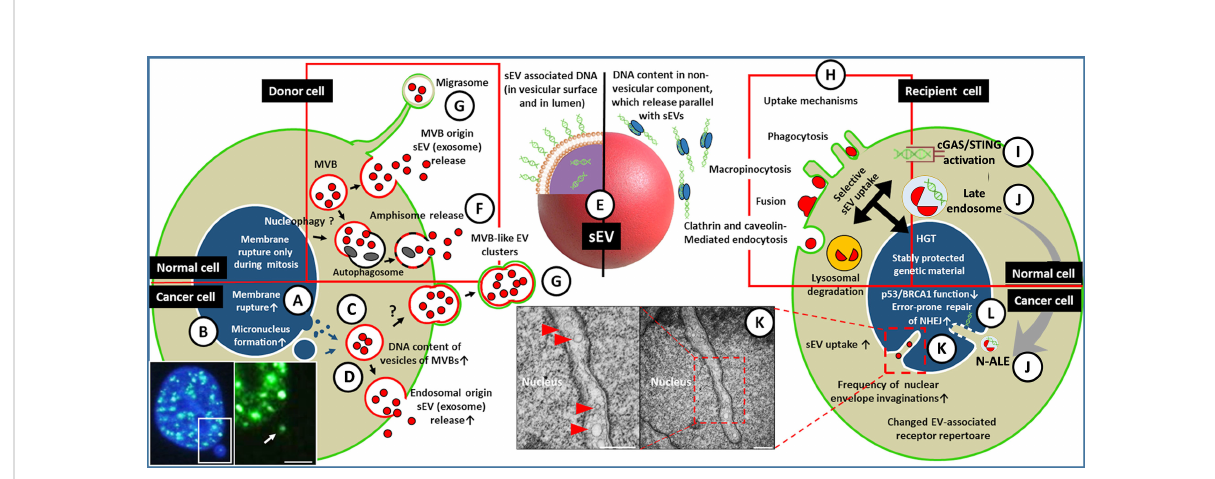
FIGURE 1 A simpli fi ed representation of sEV-mediated HGT among tumor/microenvironmental cells. (A) The nuclear gDNA is discharged to the cytoplasmic region of the EV releasing cell (left) through the rupture of the nuclear envelope or by the formation of micronucleus (the fl uorescent microscopic image shows a double-strand break (DSB) site in the micronucleus of HT-29 cell [white arrow, g H2AX staining, scale bar: 2 µm)] (B) . (C) From the cytoplasm or from micronuclei the gDNA translocates into the intraluminal vesicles (future exosomes) of multivesicular bodies. (D) Both the gDNA content of the exosomes and their release are increased in tumor cells, especially upon the effect of therapeutic stress. (E) The gDNA may be transferred either in the lumen of sEVs and/or on the exofacial EV surface, or independently as a non- vesicular component. The gDNA content of sEVs might depend on their origin, like exocytosis of MVBs (D) , amphisomes (F) , or sEV discharge from en bloc released MVB-like EV clusters or migrasomes (G) . The red frame indicates that all listed processes (i.e., migrasome formation, exosome secretion, amphisome exocytosis) may occur in both normal and tumor cells. (H) Uptake of the released sEVs by a recipient cell (right) may include receptor-mediated processes (characteristic of both normal and tumor cells, indicated by a red frame). (I) In the cytoplasm, the sEVs (or their components) may activate DNA recognition pathways e.g., cGAS/STING. (J) The EV-containing late endosomes may reach the invaginations of the nucleus (as nuclear envelope invagination-associated late endosome/N-ALE) where its parts (probably including EV-DNA) may enter the nucleus through nuclear pores. (K) Small vesicles (<200 nm) are also detectable in association with the nuclear membrane invaginations (red arrowheads in electron microphotographs of HT29 colorectal cancer cells). The origin of these vesicular structures has not been examined (scale bars: 500 nm). (L) The integration of gDNA into the recipient genome may require malfunction of the host DNA repair or onco-suppressor mechanisms (e.g., p53, and BRCA1). Many of the processes presented here have only been described in relation to cancers. Further studies are needed to demonstrate whether these occur in healthy